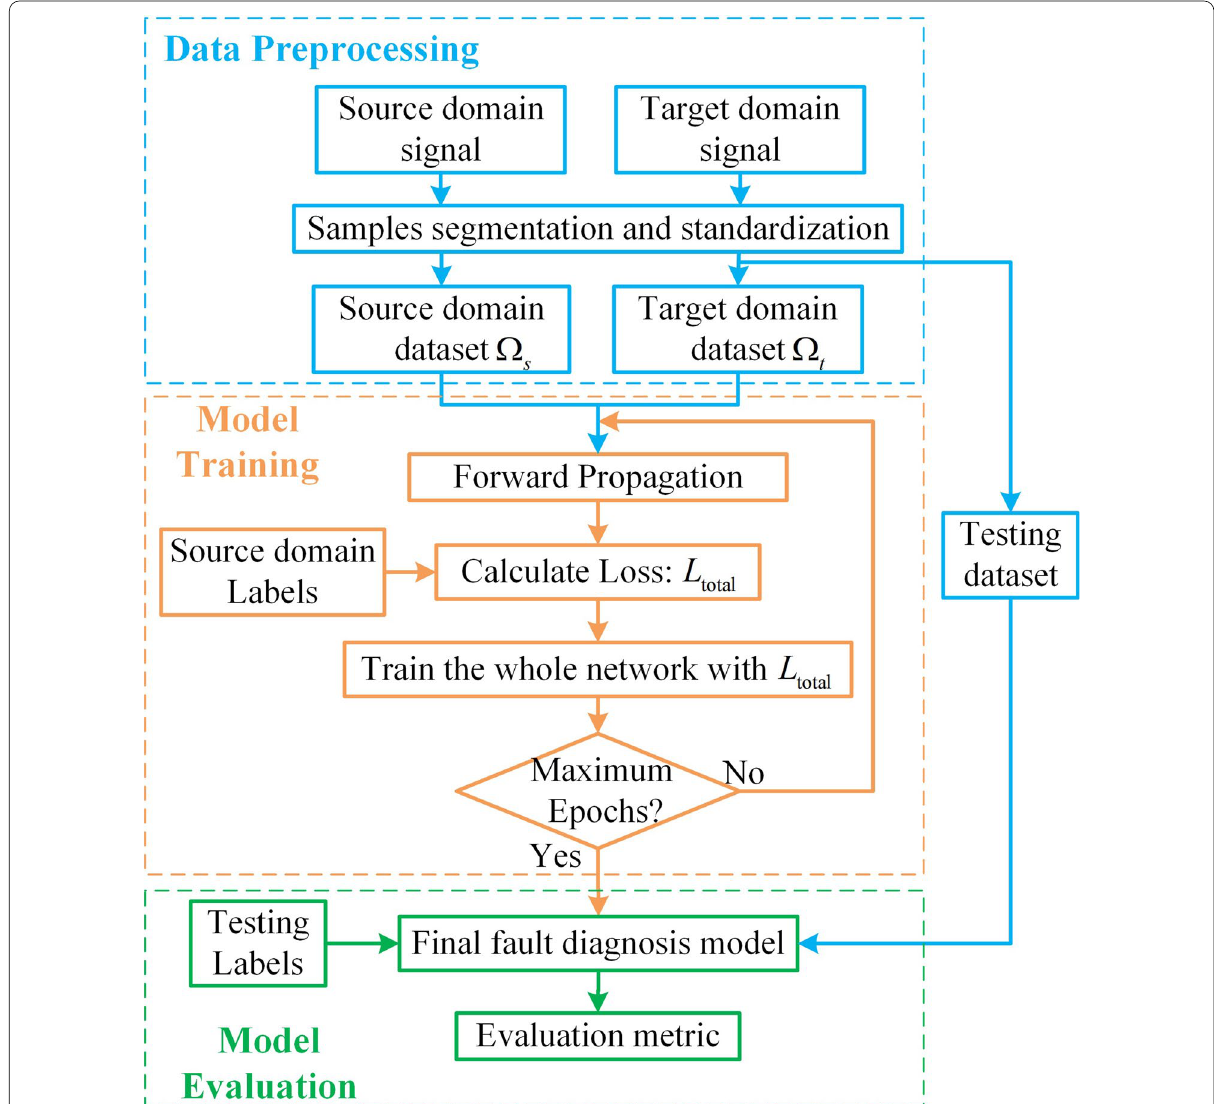
Figure 2 Flowchart of